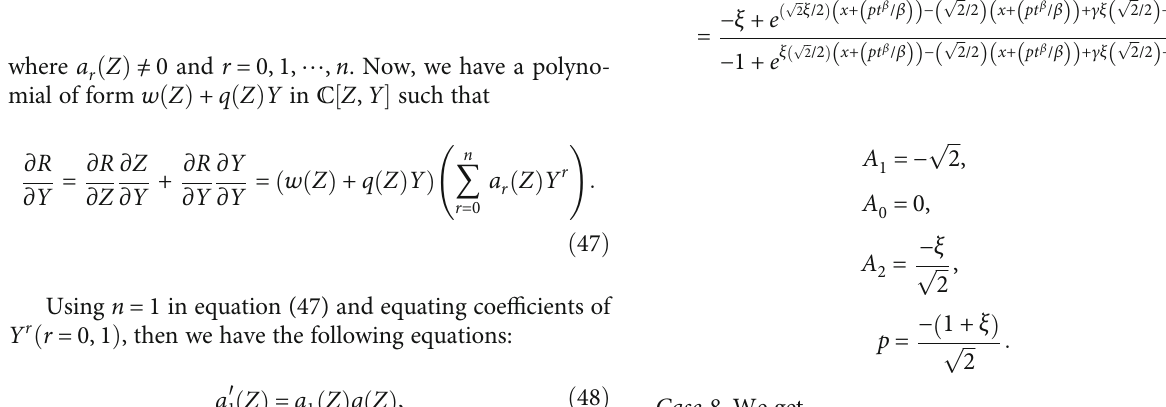
Figure 3: 2D plot of conformable fractional KPP equation (Case 1) using η = 2 : 1 , m = 1 , δ = 1 , μ = 1 , γ = 1 , and β = 0 : 8